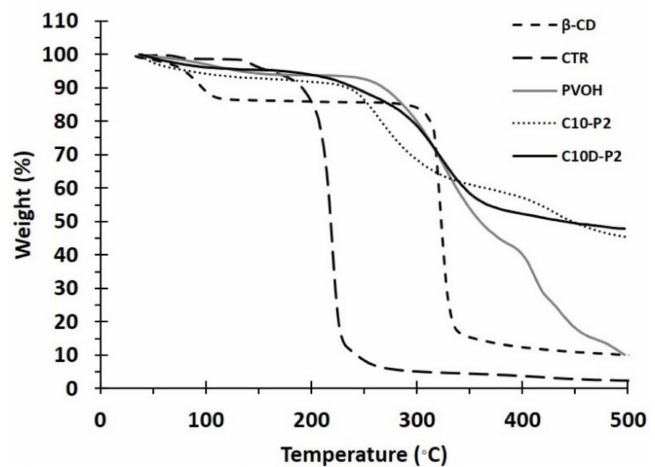
Figure 4. TGA thermograms of nanosponges and